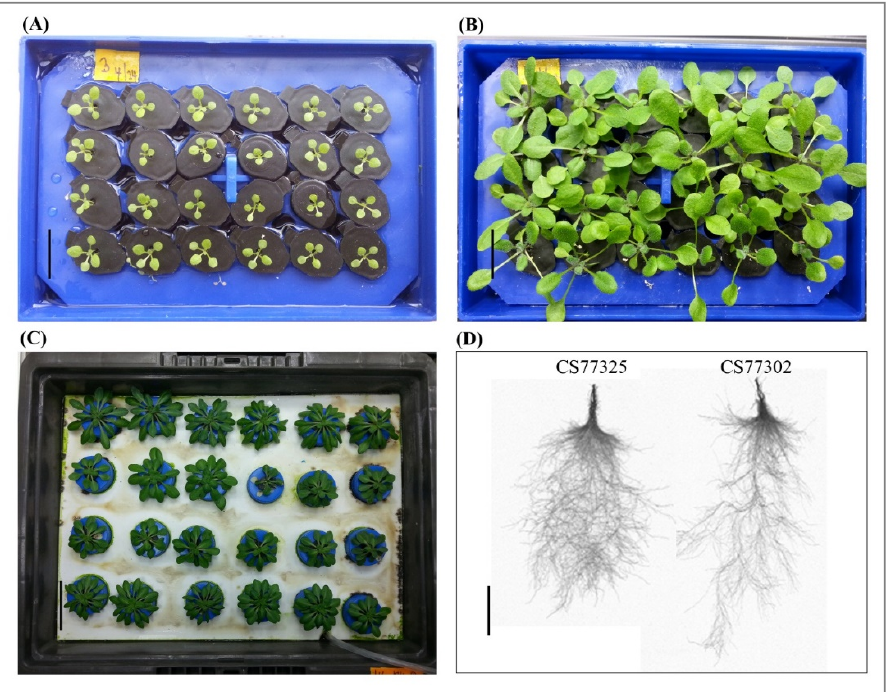
Figure 1. Hydroponics growth methodology adopted for phenotyping. Flow chart outlining the key steps in the process of growing seedlings till phenotyping. Seedlings were grown in small floating racks for ( A ) 10 days and ( B ) 21 days before moved into big trays for ( C ) another three weeks. Images of ( D ) 42-day-old seedlings were documented using WinRHIZO software. Scale: ( A , B ) 1 cm; ( C ) 3 cm; and ( D ) 4 cm.